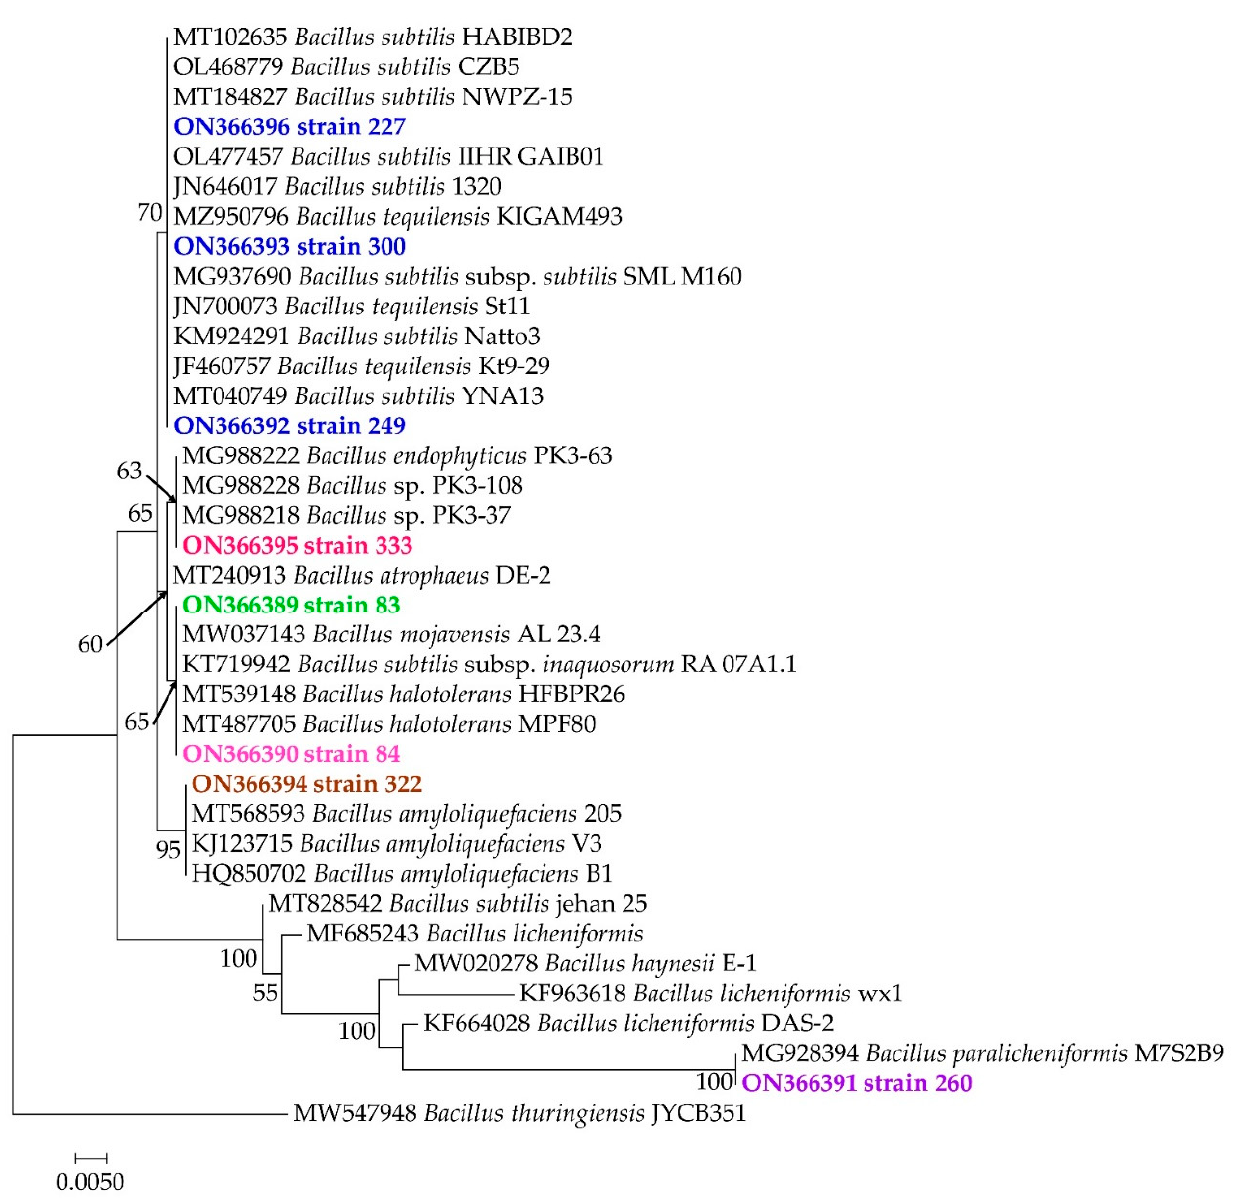
Figure 5. Maximum likelihood phylogenetic tree of Bacillus strains (227, 300, 249, 333, 83, 84, 322, and 260) based on a comparison of the 16S-rRNA gene sequence of bacterial strains with some phylogenetically related strains. Supports for branches were assessed by bootstrap resampling of the dataset with 1000 replicates.